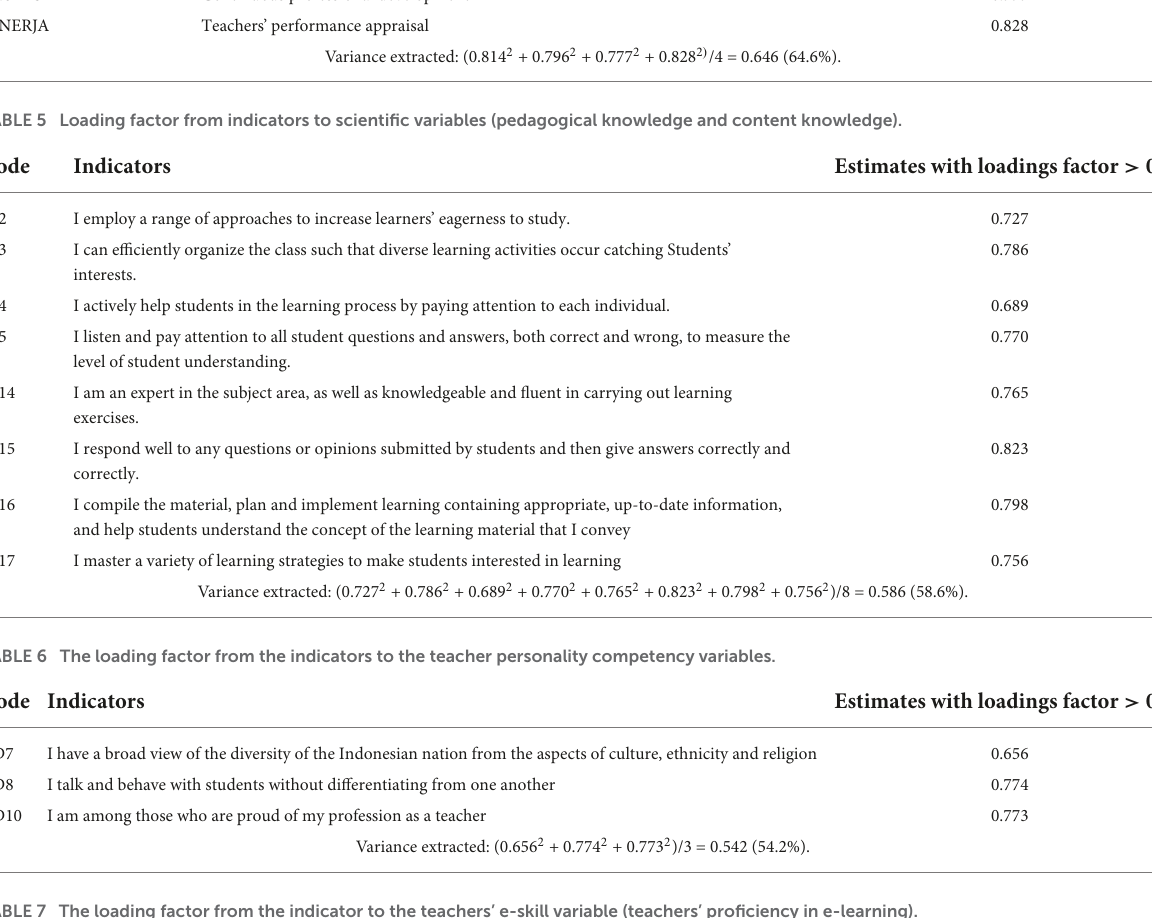
TABLE 7 The loading factor from the indicator to the teachers’ e-skill variable (teachers’ proficiency in e-learning). Code Indicators